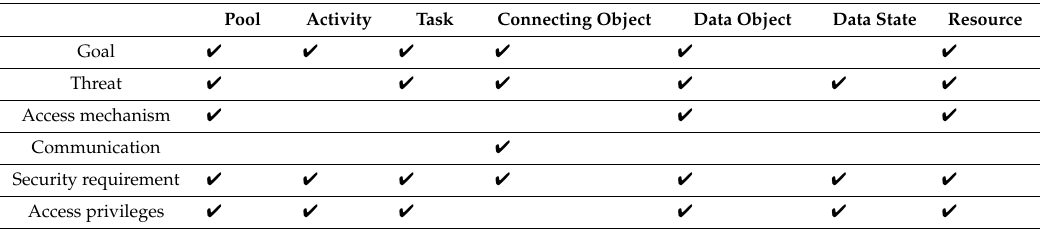
Table 4. Mapping of extended security objects with basic elements of